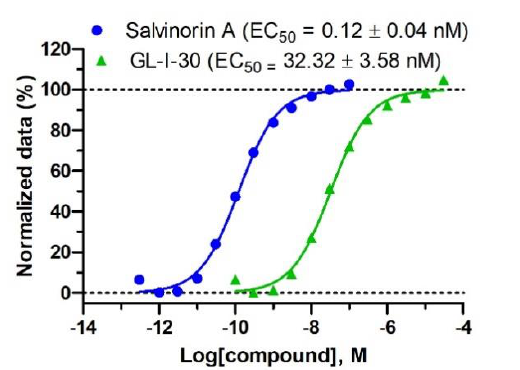
Figure 2. BRET recruitment assay. HEK293 cells were transfected with G α oA -RLuc, G β 3, G γ 8-GFP2 and human KOR and treated with increasing concentrations of GL-I-30 or full agonist salvinorin A. Luminescence ratio data at 400 nm and 515 nm were normalized to vehicle and 10 nM salvinorin A. Non-linear regression was used to determined EC 50 values. Data n = 24 is depicted as mean and SEM.